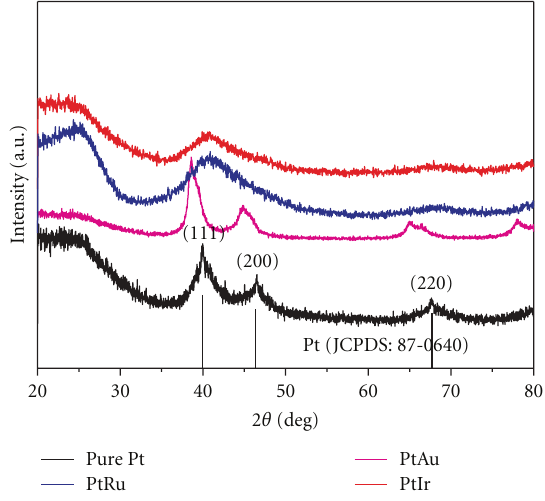
Figure 3: XRD spectra of pure Pt and bimetallic